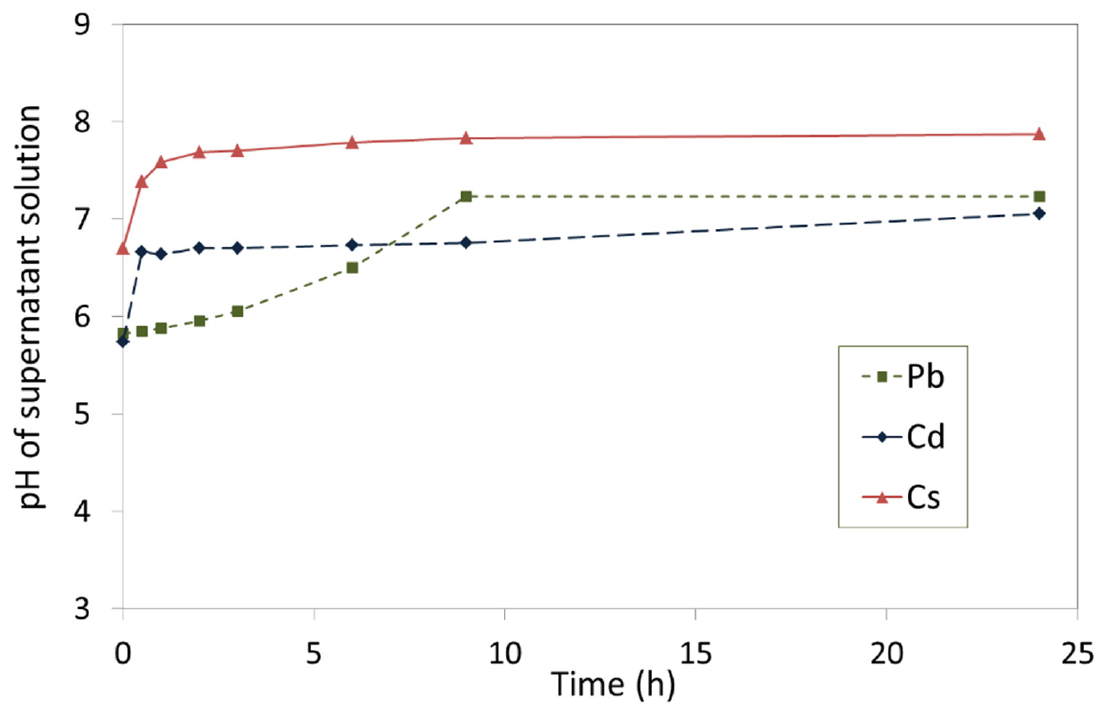
Figure 6. Uptake of Pb 2+ , Cd 2+ , and Cs + by the 7-day hydrothermal product.